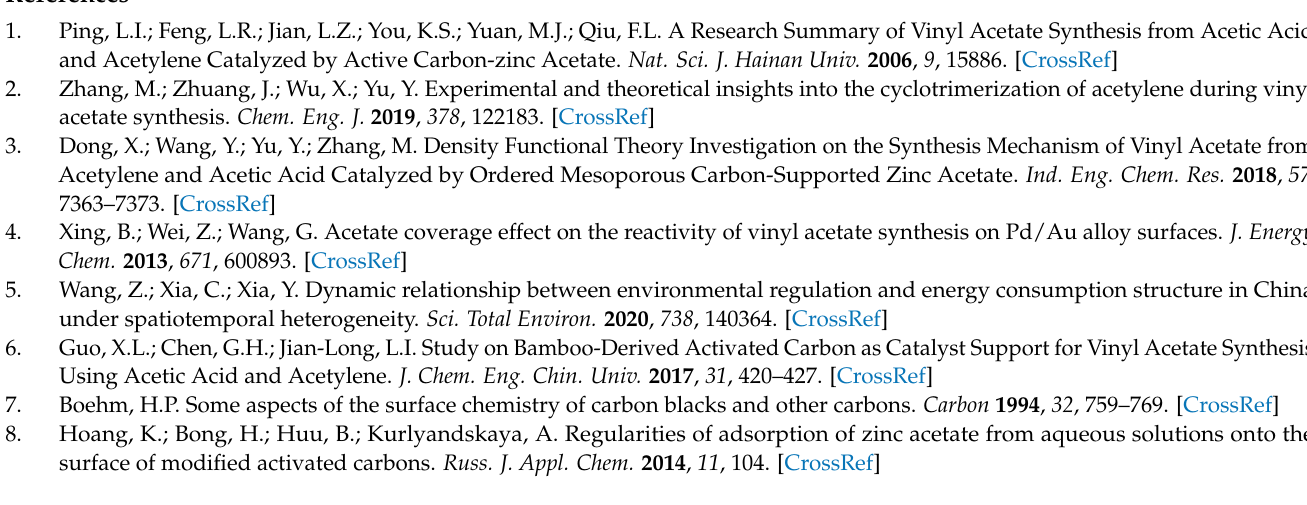
Figure S2: Reactivity of catalysts with time. (For ease of differentiation, the catalyst in this picture was named after the added ligand.), Figure S3: XPS analysis of the contents of each element (a) and C 1s (b) of Zn-O-C, Zn-O/N-C, and Zn-N-C, Figure S4: XRD patterns in each reaction stage of Zn-O-C catalyst, Figure S5: TPD analysis of Zn-O-C and Zn-N-C catalysts for CH 3 COOCHCH 2 , Table S1: Specific surface area, pore volume, and pore size data of each